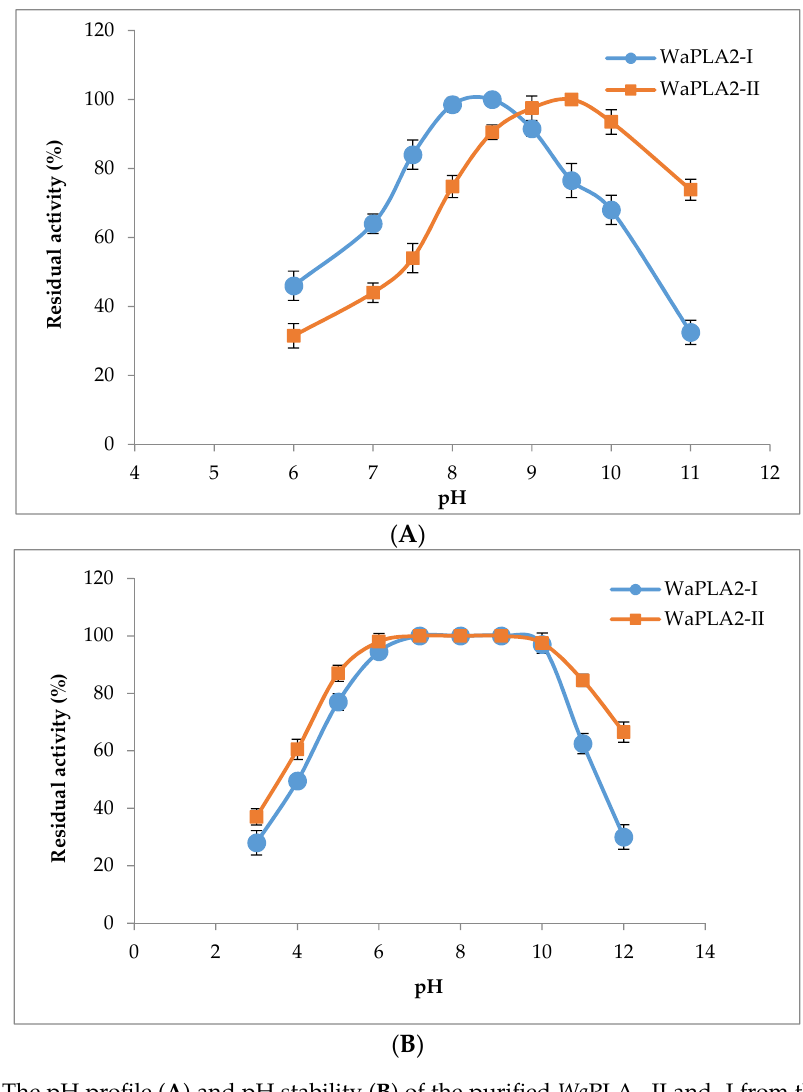
Figure 2. The pH profile ( A ) and pH stability ( B ) of the purified Wa PLA 2 -II and -I from the venom of W. aegyptia sPLA2 activity was assayed in a pH range from 6.0 to 11.0 at optimal temperature (60 °C). The maximum activity of Wa PLA 2 -II obtained at pH 9.5 was designated as 100% activity. The pH stability of the two enzymes was determined by incubating the enzymes in different buffers for 30 min at room temperature and at different pH values (3–12), and the residual enzyme activity was determined under standard assay conditions. The control represents 100% of PLA2 activity at 10 mM Ca 2+ under the same conditions. The results represent the means of three independent experiments and expressed as the mean ± SD (n = 3).